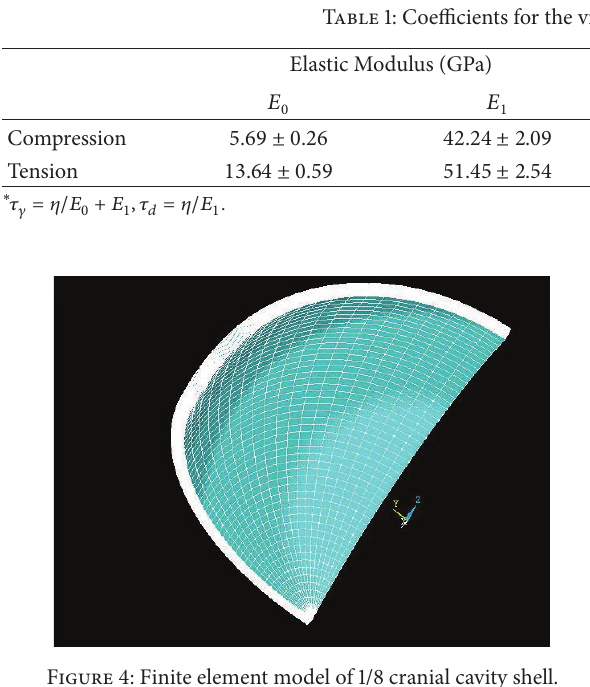
Figure 4: Finite element model of 1/8 cranial cavity shell.